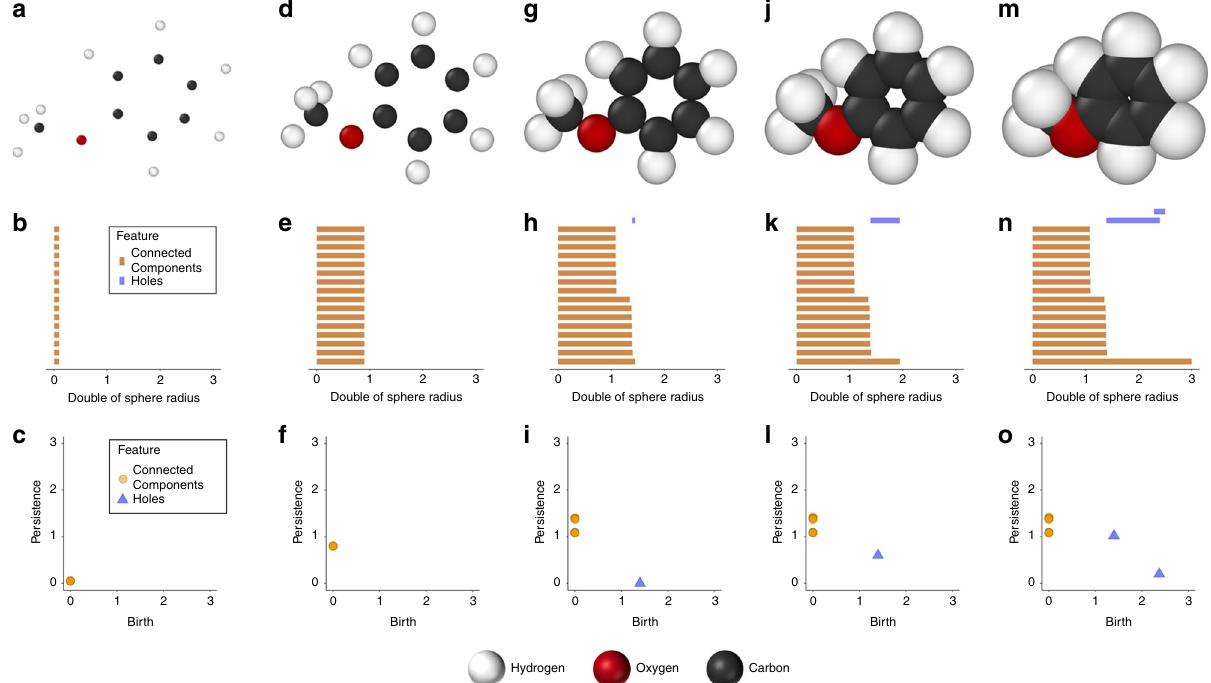
Fig. 1 Graphical representation of the evolution of the persistent diagram (PD) for anisole. a Each atom of anisole is represented by a point. Each connected component is born at time birth = 0 in the evolution of b homological features plot and c PD. Each bar at the evolution plot tracks the connected components or holes. Note that there are 16 overlapping points in the PD associated with the number of atoms. d – f The radius of a sphere centered at each atom is increased, and the connected components continue to persist so the persistence of a connected component is not in its fi nal location. g – i When the radius increase leads to sphere overlap between atom pairs, the connected components on the PD are fi nalized. A hole is created by the six carbon atoms of the phenyl group, and a blue triangle appears in the persistence diagram to indicate its birth. j – l The radius is again expanded, and the hole (phenyl ring) still persists. m – o A second hole is formed between the methoxyl group and the two carbons of the phenyl group. The death of both holes occurs when their corresponding spheres intersect. The fi nal PD is obtained when the death of all but one connected component and all holes are observed. Note that the bottom bar never terminates and it is always excluded from the